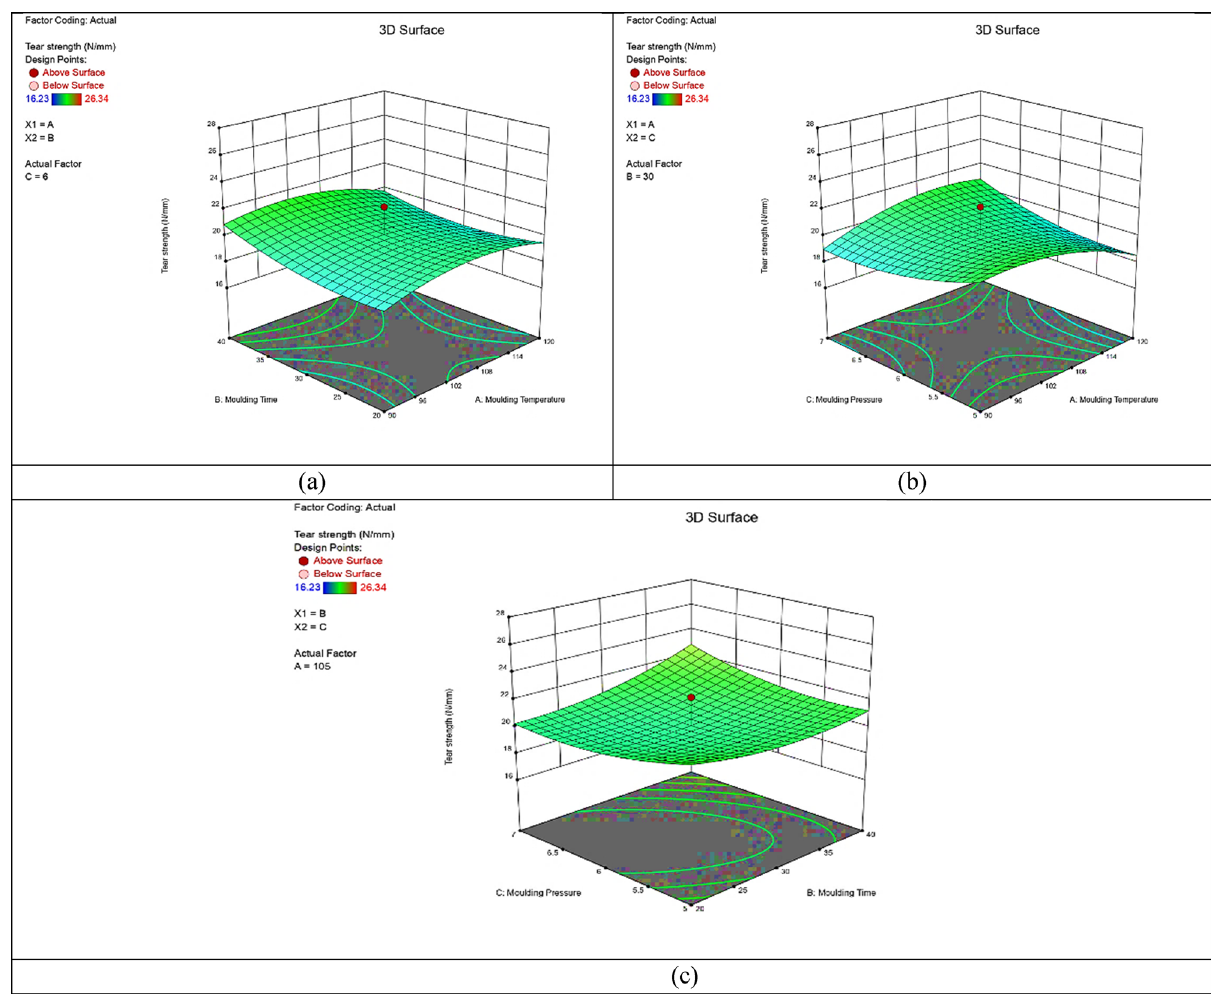
Figure 19: ( a – c ) 3D interaction plots for tear strength of leather bu ffi ng dust reinforced recycled EVA polymer composites.